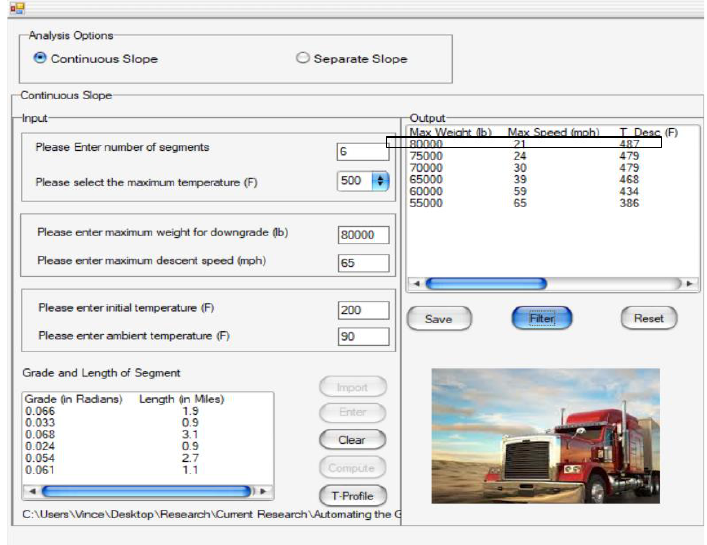
Figure 9: Output for continuous slope method of analysis highlighting maximum weight, maximum speed, and temperature of descent (validating Figure